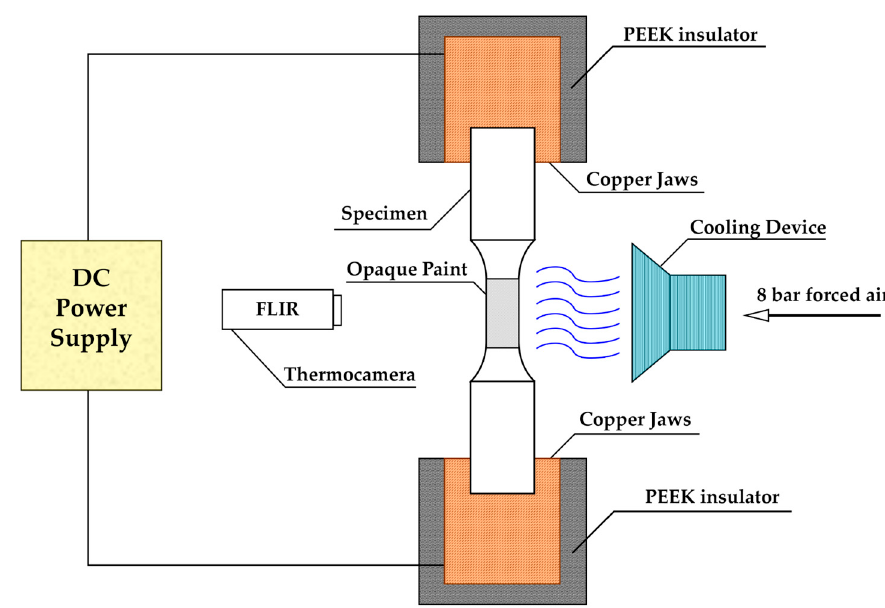
Figure 1. Schematic of tensile test machine setup for electroplastic tensile